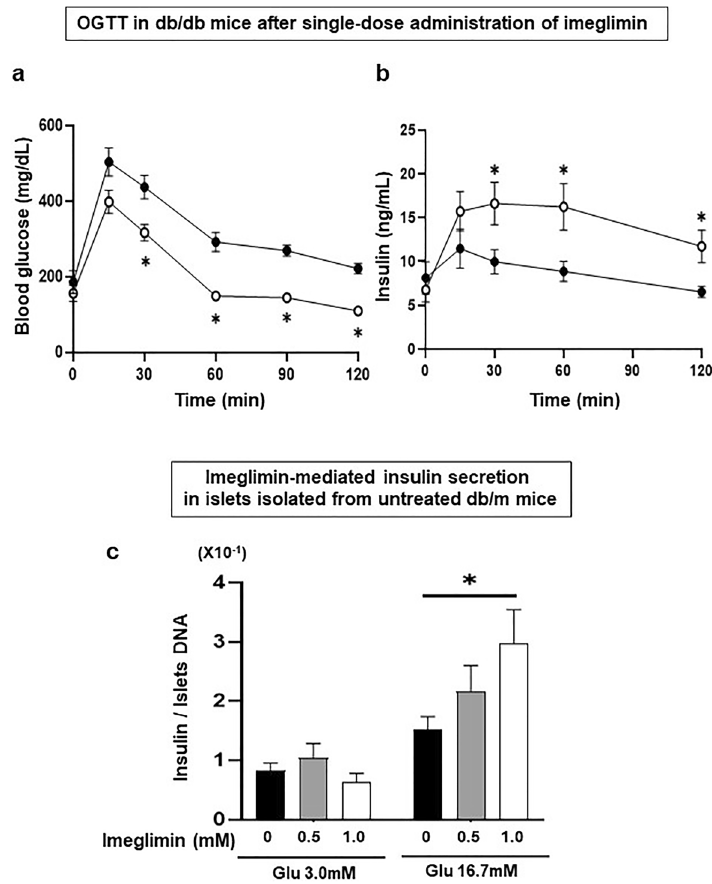
Figure 1. ( a , b ) Effects of single-dose administration of imeglimin on blood glucose and serum insulin levels in obese type 2 diabetic db/db mice. In oral glucose tolerance test after single-dose administration of imeglimin in 7-week-old db/db mice, blood glucose levels were significantly lower in the mice treated with imeglimin together with significant increase of insulin secretion compared to those without the treatment (control: black circle, imeglimin: white circle, n = 6). ( c ) Effects of single-dose administration of imeglimin on glucose- stimulated insulin secretion in pancreatic islets isolated from non-diabetic db/m mice. Insulin secretion was significantly augmented by imeglimin in a dose-dependent manner under a high glucose concentration, but not in a low glucose concentration, in islets isolated from db/m mice (db/m mice, n = 9–10). Values are the mean ± SEM of data obtained from each group. * p <